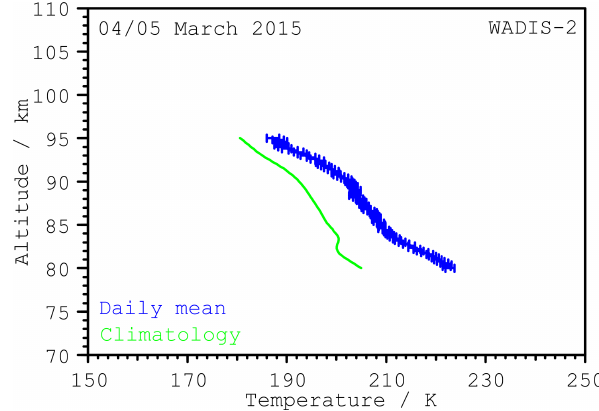
Figure 4. Daily mean temperature profile (WADIS-2 day) com- pared to the profile from the climatology for the same day of the year. Only altitudes with 24h observation time are